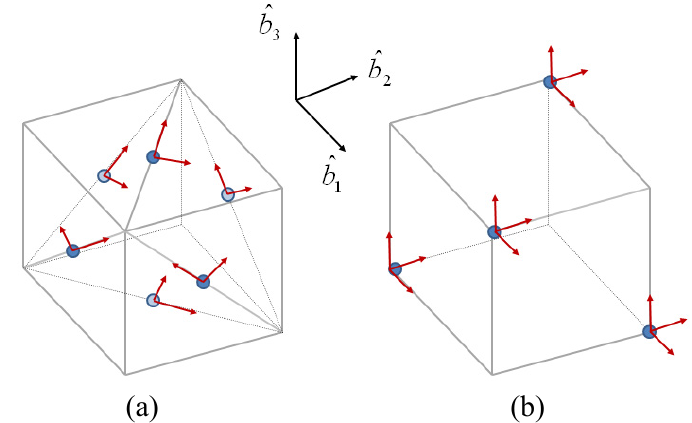
Figure 2. Two possible configurations ( a ) configuration A; ( b ) configuration